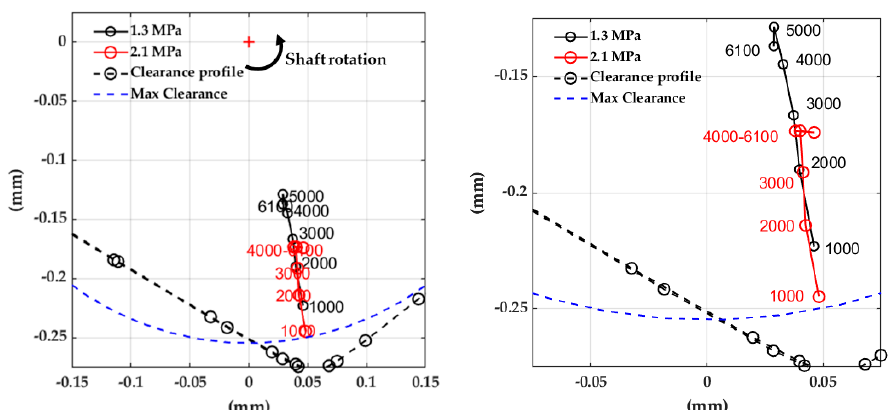
Figure 14. Flooded Rocker Pivot bearing shaft centerline with detail on the right.